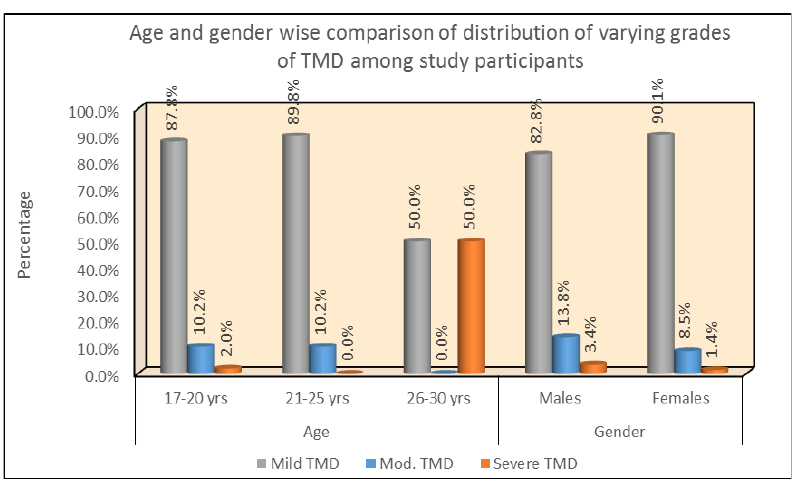
Figure 1: Age and gender wise comparison of distribution of varying grades of TMD among study participants